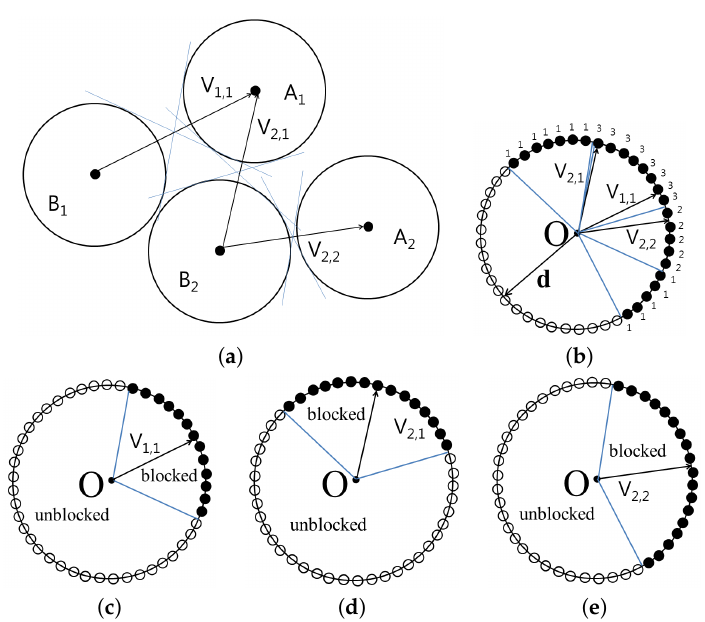
Figure 3. Example of computing blocked directions. ( a ) the relative positions of A 1 , A 2 , B 1 and B 2 ; ( b ) the cone consructed for three pairs ( A 1 , B 1 ), ( A 1 , B 2 ) and ( A 2 , B 2 ); ( c ) the cone for A 1 and B 1 ; ( d ) the cone for A 1 and B 2 ; and ( e ) the cone for A 2 and B 2